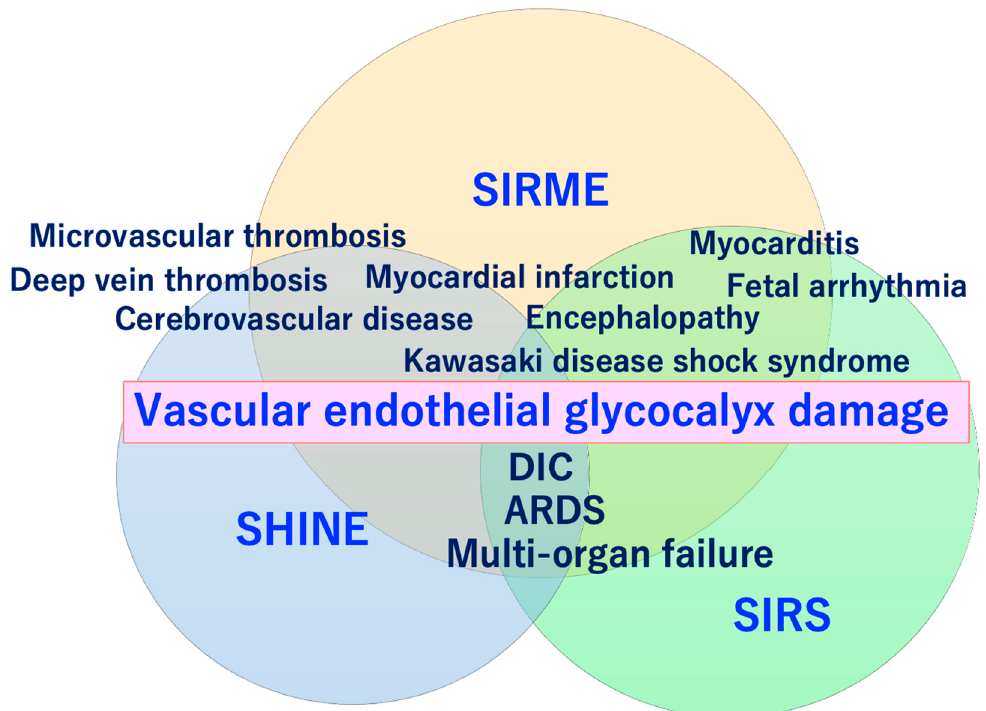
Figure 10. Conceptual diagram showing the relationship between shock-induced endotheliopathy (SHINE) / systemic inflammatory-reactive syndrome (SIRS) and the vascular endothelial glycocalyx (VEGLX) damage that causes systemic inflammation-reactive microvascular endotheliopathy (SIRME). SIRME is caused by a systemic disorder of the VEGLX, resulting in extravascular leakage of plasma components, increased thrombogenicity, increased production of reactive oxygen species, and an excess state of inflammatory cytokines, leading to microvascular embolism, venous thrombosis, and Kawasaki disease shock syndrome. As the disease worsens, it progresses to severe SIRME, including the concept of SIRS and SHINE, leading to severe conditions such as disseminated intravascular coagulation (DIC) and acute respiratory distress syndrome (ARDS).